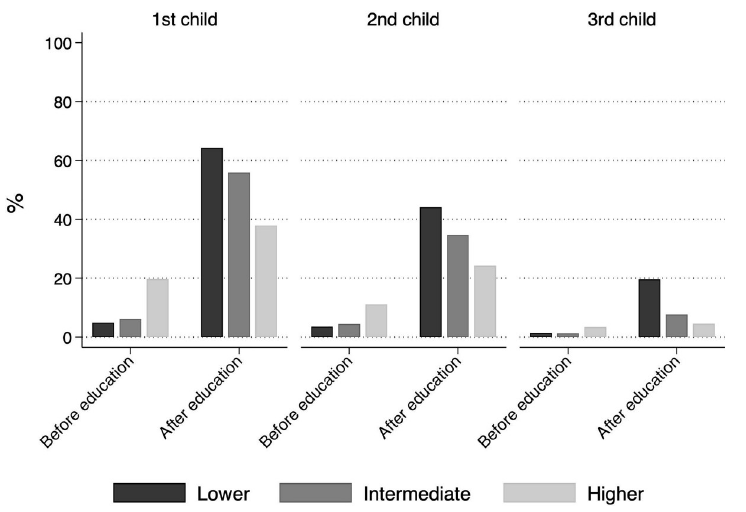
Fig 1. Timing of motherhood by education. Data are from SOEP, v.34; own calculation.